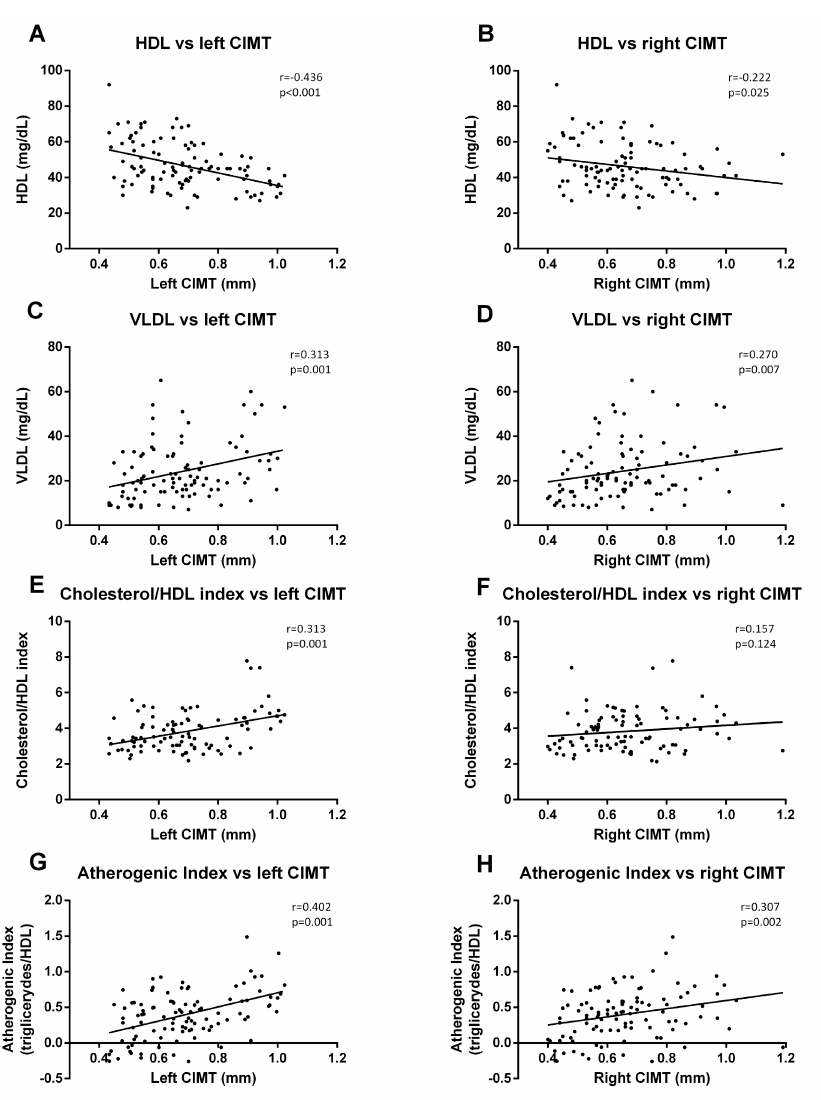
Figure 6. Correlation graphs of lipid metabolism parameters vs. CIMT measurements . Graphs show a correlation of HDL-c with left ( A ) and right CIMT ( B ); of VLDL index with left ( C ) and right CIMT ( D ); of cholesterol / HDL-c index with left ( E ) and right CIMT ( F ); and of atherogenic index (AIP) with left ( G ) and right ( H ) CIMT. A Spearman correlation analysis was performed. r coefficient and statistical significance, if any existed, are shown in the graph.